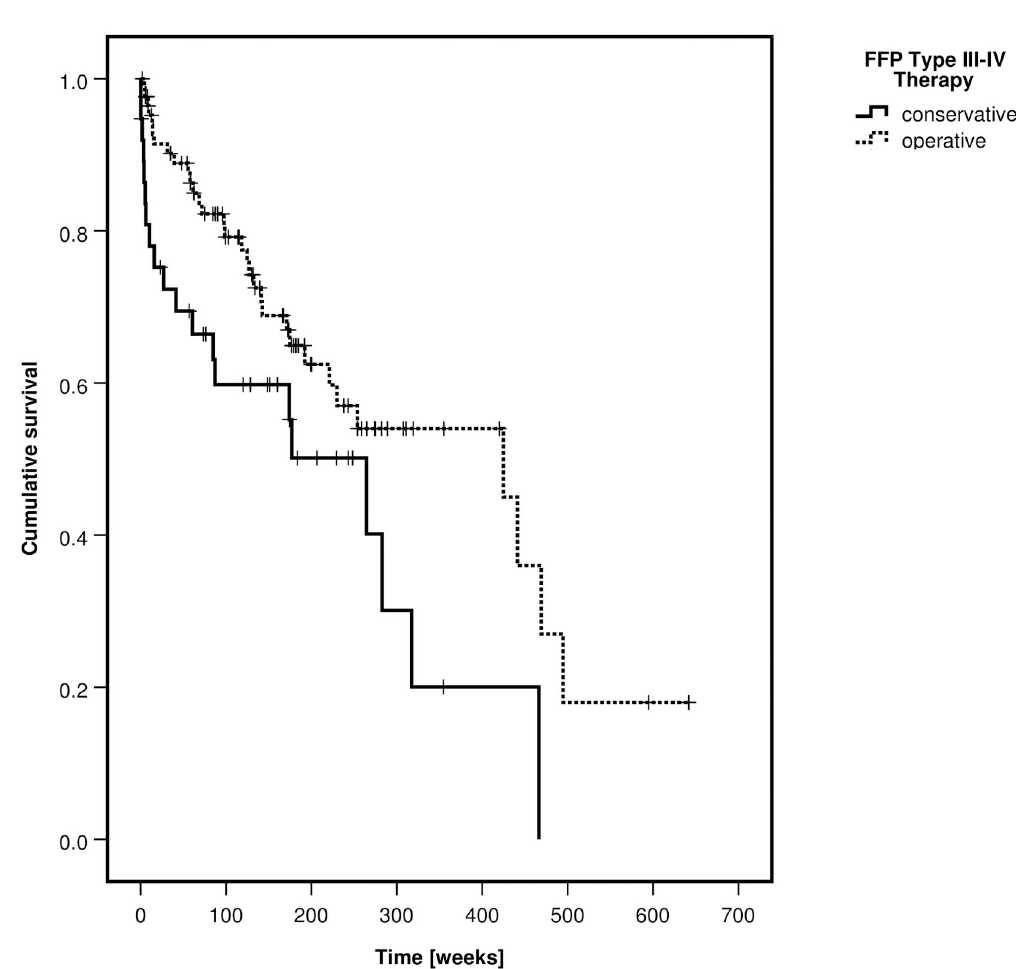
Fig 6. Kaplan-Meier curve of cumulative survival, depending on type of treatment—FFP type III and type IV patients.